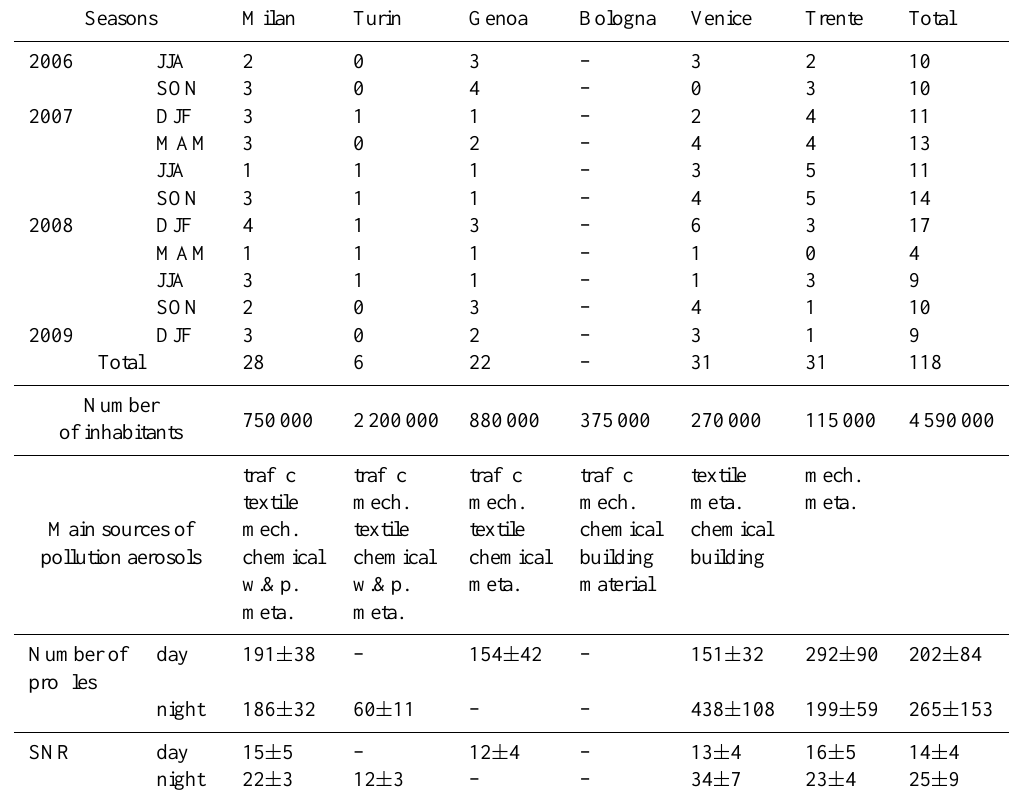
Table 1. Seasonal and spatial distributions of CALIOP level-1 data in cloud-free conditions over the Po Valley from June 2006 to February 2009. The nearest big cities flew over by CALIPSO are given with their numbers of inhabitants and the main aerosol sources. The mean number of profiles and the corresponding SNR in the PBL are also specified for each